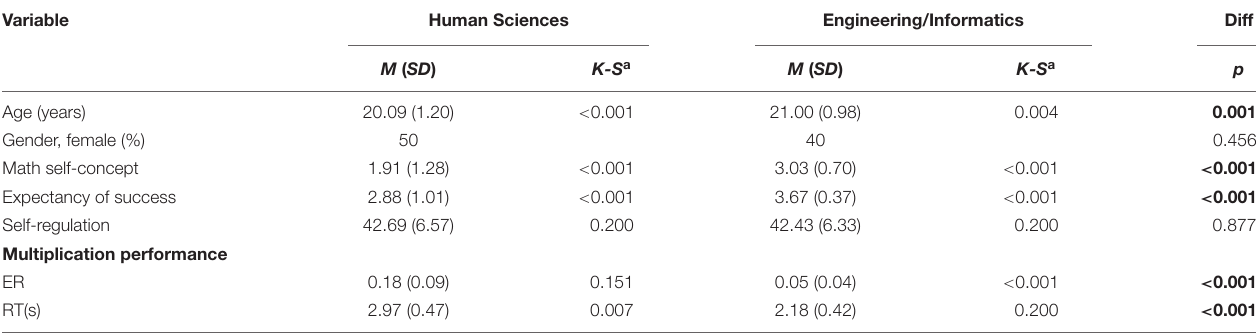
TABLE B4 | Descriptive of Iranian students of Human Sciences and Engineering/Informatics.